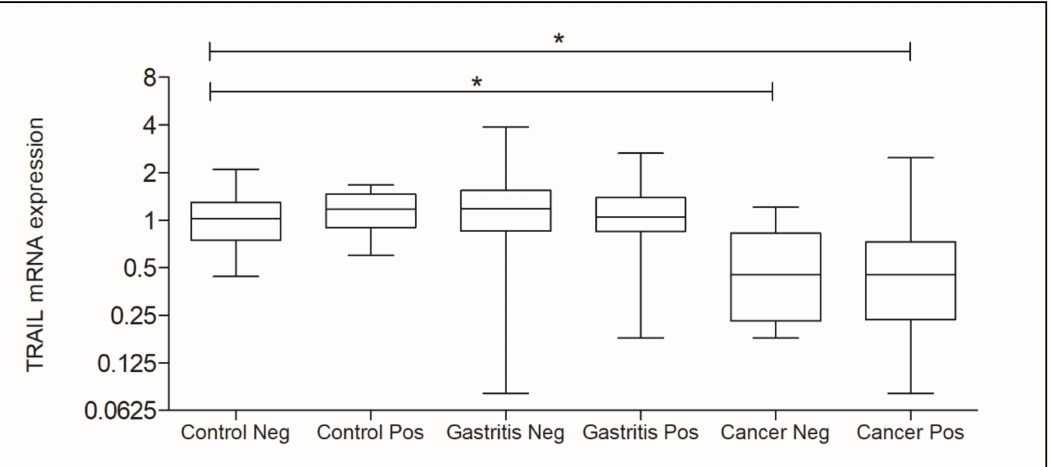
Figure 3. Analysis of TRAIL gene expression for the presence of H. pylori in Control, Gastritis, and Cancer groups. Legend: Neg.: Negative; Pos.: Positive. *statistically